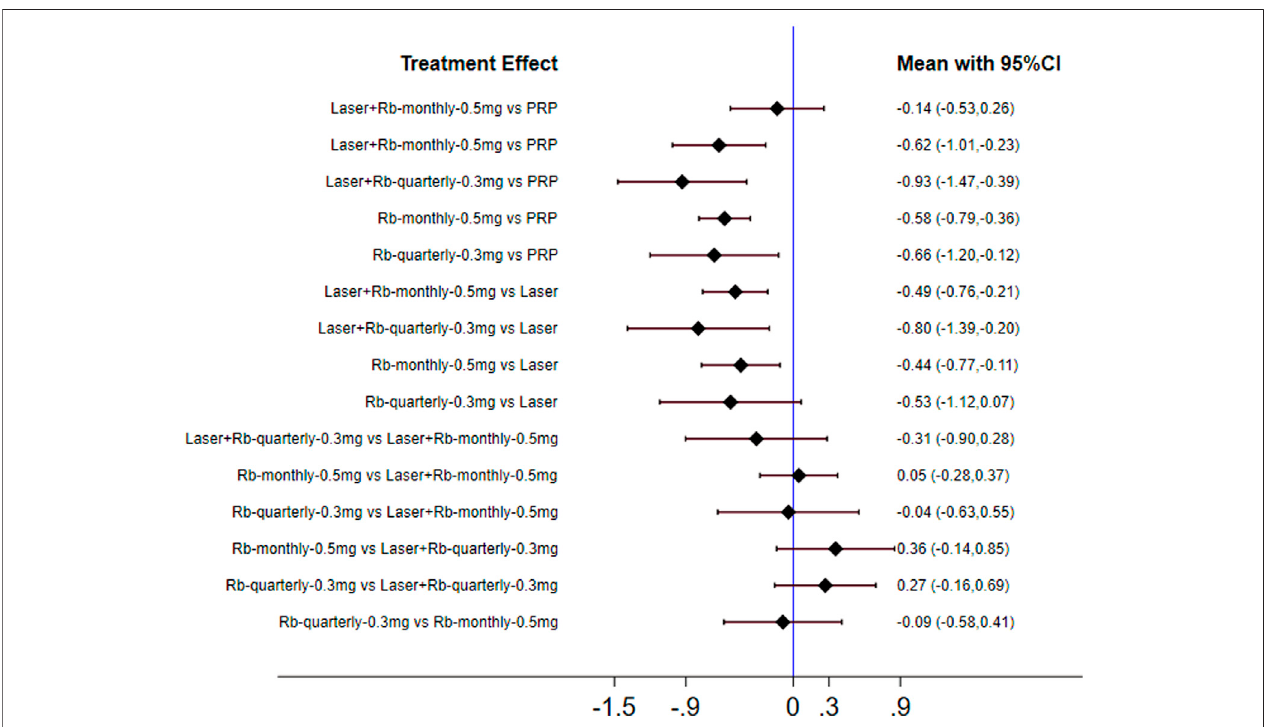
FIGURE 7 | Forest plots for subgroup analysis of central retinal thickness. Horizontal lines indicate the range of 95% CI. Abbreviation: Ranibizumab (cid:1) Rb.